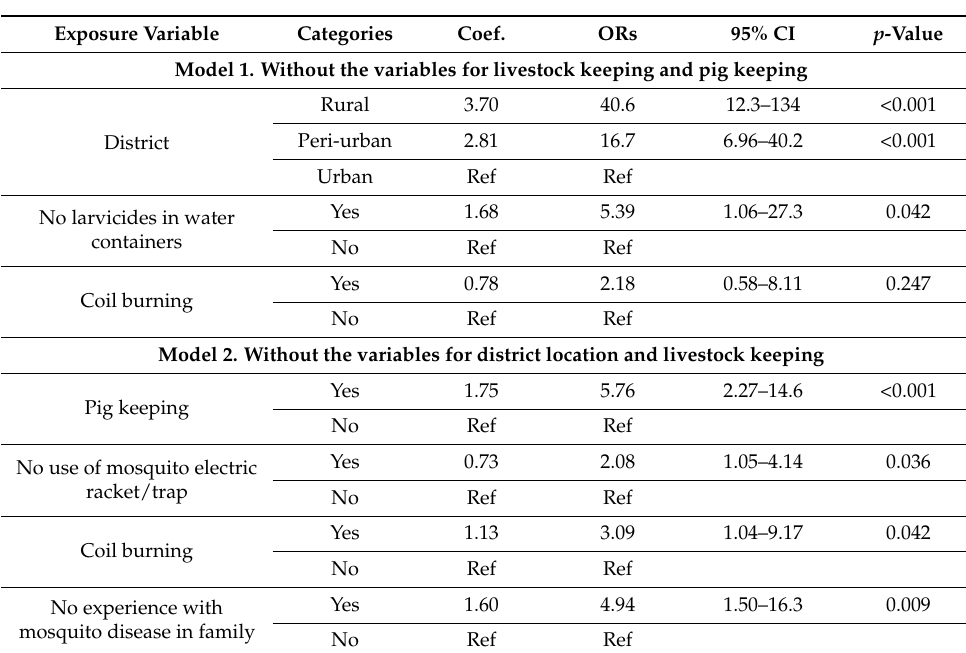
Table 4. Final multivariable analysis of risk factors for dog-keeping